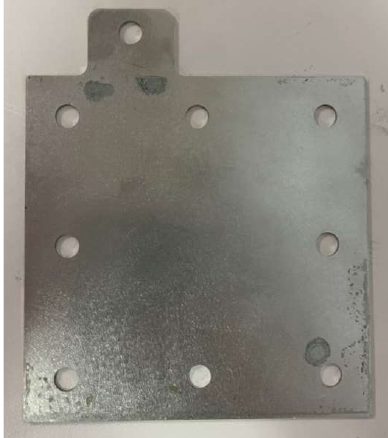
Figure 12. Metal collector plate.